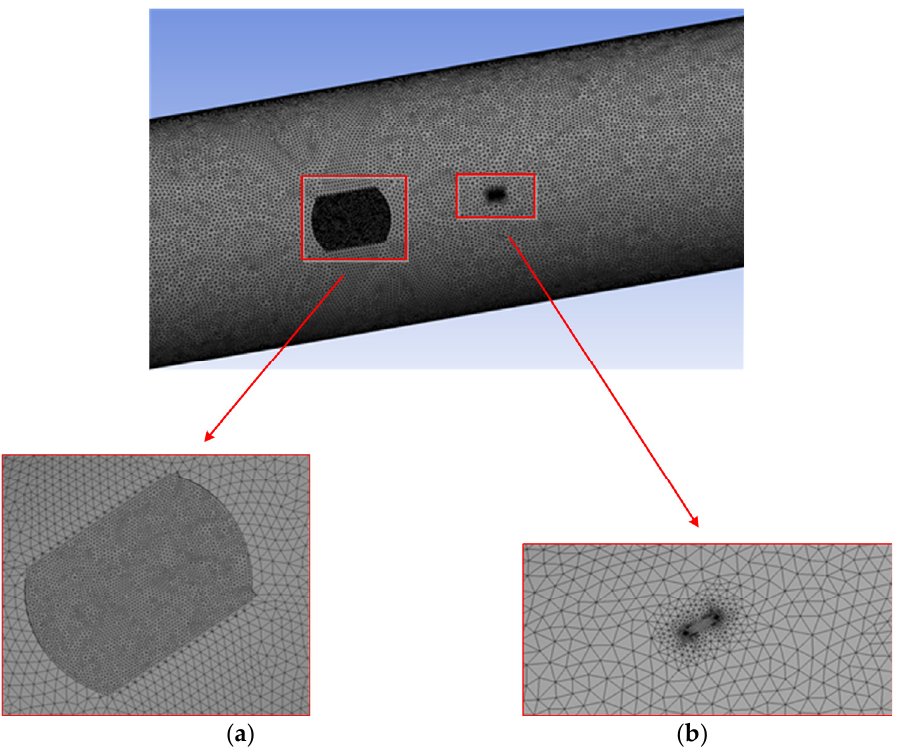
Figure 2. The grid division of pipeline. ( a ) Partial refinement of corrosion defect grid. ( b ) Partial refinement of grid at crack. Table 1. Parameters of the pipeline [21].